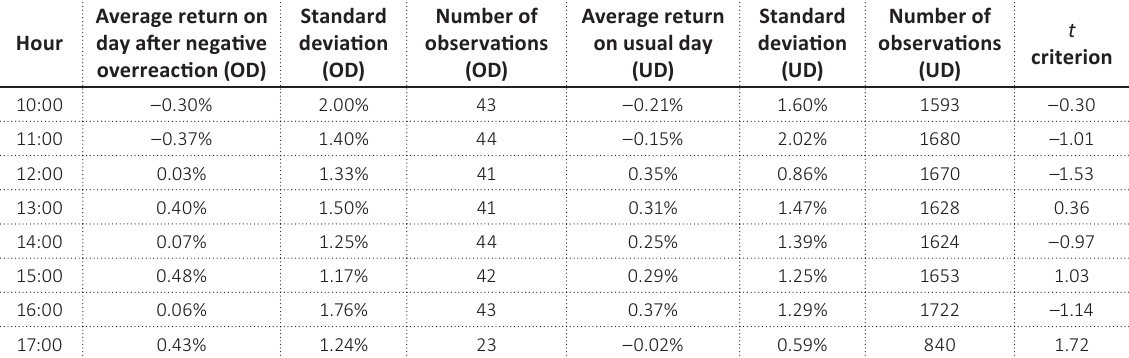
Table 6. T -test of hourly returns on the day after the overreaction and normal days: case of negative overreactions,